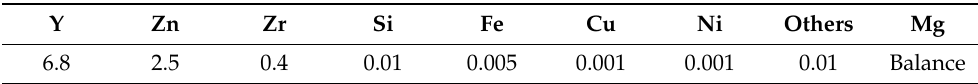
Table 1. Chemical composition of WZ73 (wt. %) alloy as determined by means of optical emission spectrometry